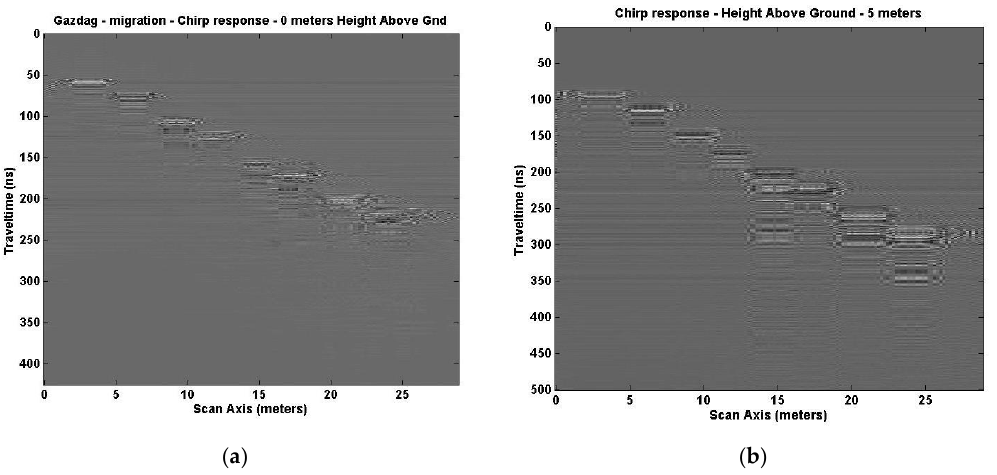
Figure 16. ( a ) Gazdag [17] translated SA2 model output from chirp excitation with Tx/Rx at 0.15 m. ( b ) Gazdag [17] translated SA2 model output from chirp excitation with Tx/Rx pair at 5 m.